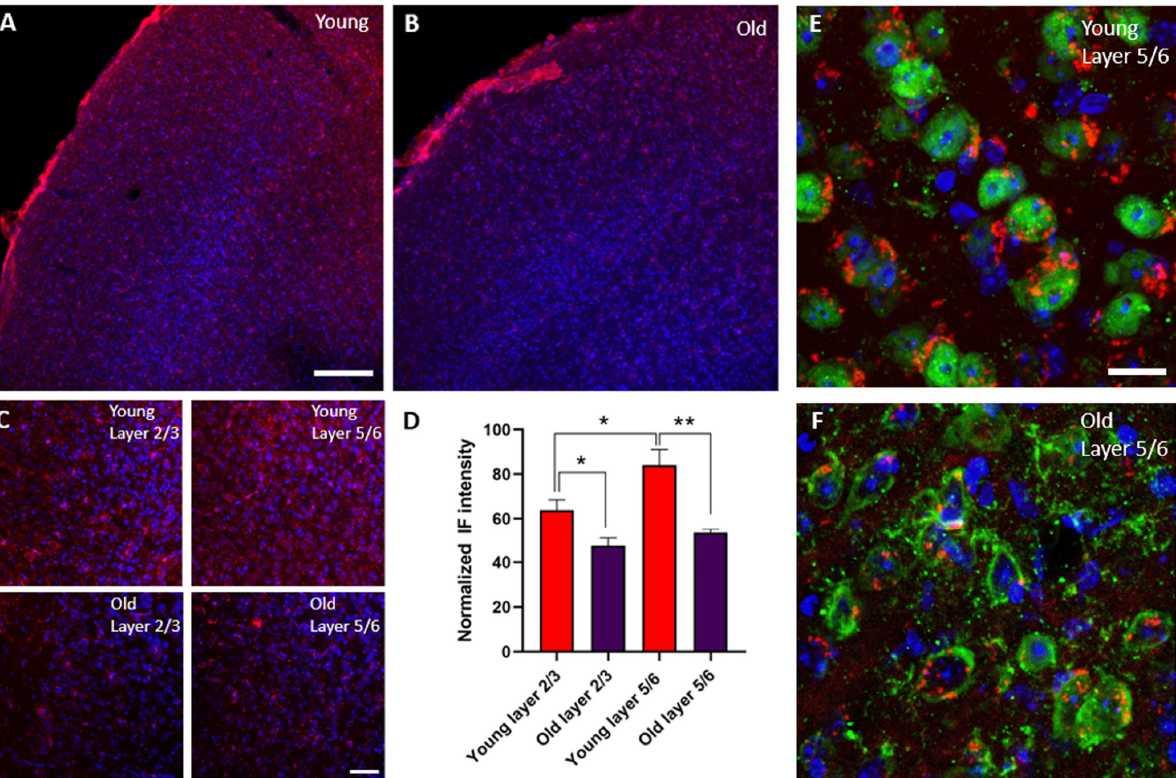
Figure 4. The expression of IGF-1R was reduced in old animals. ( A , B ) Panoramic view of double immunocytochemistry in the S1 cortex at low magnification showing staining of IGF-IR (red) and DAPI (blue) in young and old animals. A reduction in IGF-IR expression was observed in all cortical layers in old animals. ( C ) Photomicrographs of double immunocytochemistry in the S1 cortex. Infragranular layer (5/6) showed higher expression of the IGF-IR in young animals. ( D ) Comparisons of densitometric measurements for IGF-1R in layers 2/3 and 5/6 of young and old animals. Values of the optical density are represented as means ± SEM of the normalized fluorescence intensity . Young animals showed a higher expression of IGF-IR in layer 5/6 compared with layer 2/3 (n = 6; p = 0.01). A clear reduction in IGF-IR was observed in all cortical layers of old compared with young animals (layer 2/3 young vs. old n= 6; *, p = 0.018 and layer 5/6 young vs. old n = 6; **, p = 0.0016). ( E , F ) Representative high-magnification photomicrographs of neurons located in layer 5/6 showing staining of IGF-IR (red) and NeuN (green) in young and old animals. Most IGF-IR staining was located on cortical neurons and was reduced in old animals. Scale bar in A and B: 120 μ m. Scale bar in C: 38 μ m. Scale bar in E and F: 15 μ m.